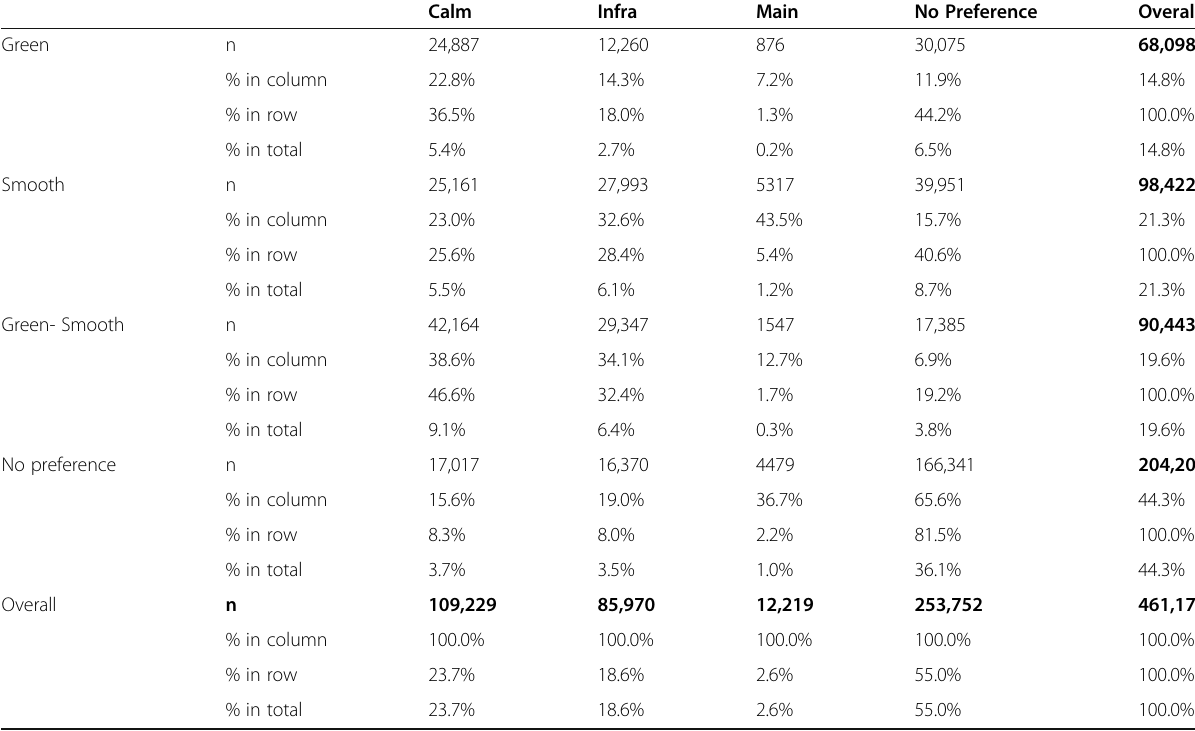
Table 3 Distribution of preferences for road categories (x-axis) intersected with preferences for other characteristics (y-axis)